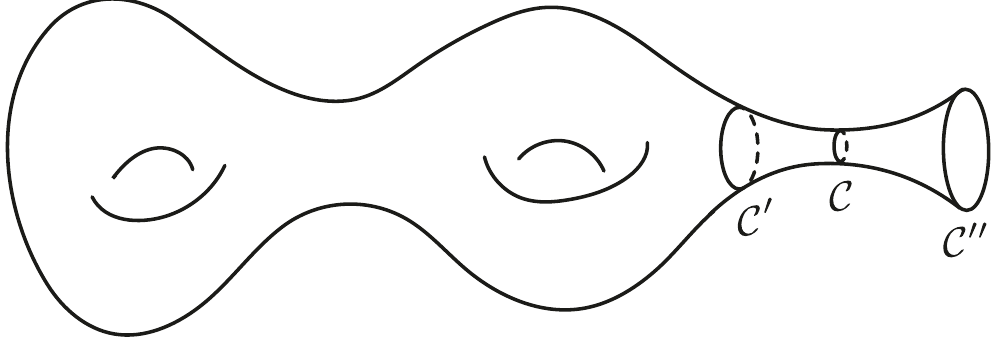
Figure 1 . Example of a genus two surface M with one boundary. The boundary is originally at C , which has length ‘ and constant extrinsic curvature k , but it can be moved to C 0 or C 00 , which have ( ‘ 0 , k 0 ) and ( ‘ 00 , k 00 ) , without changing the partition function. As explained in the main text, ‘ 2 (1 − k 2 ) must be invariant and the partition function depends only on this combination of